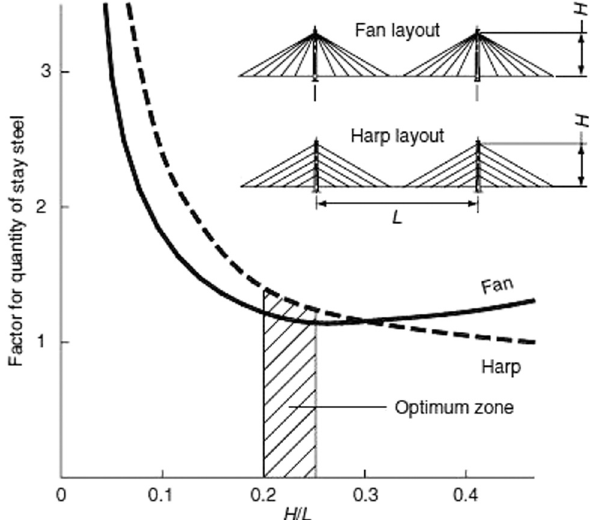
Figure 7: Optimum pylon